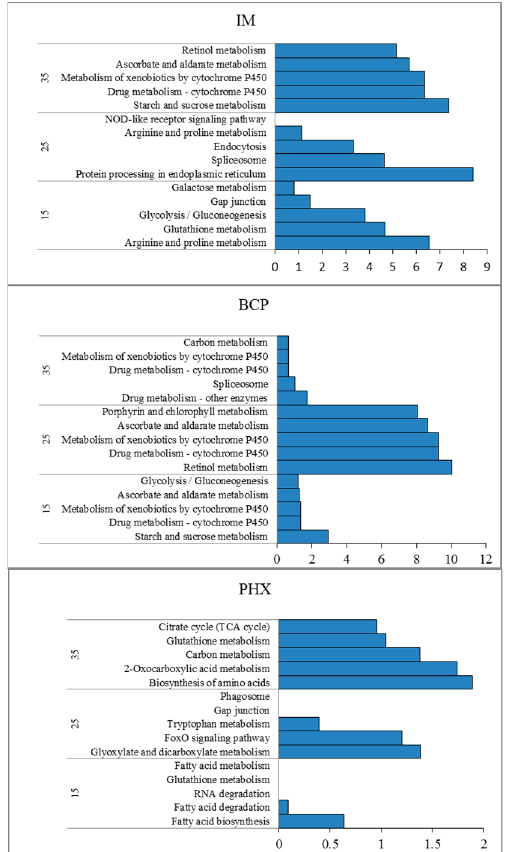
Figure 4. KEGG pathway enrichment analysis of the top five pathways in three treatments. IM is the abbreviation of imidacloprid, BCP is beta-cypermethrin, and PHX is phoxim. Enrichment scores are shown as − log10( q ).